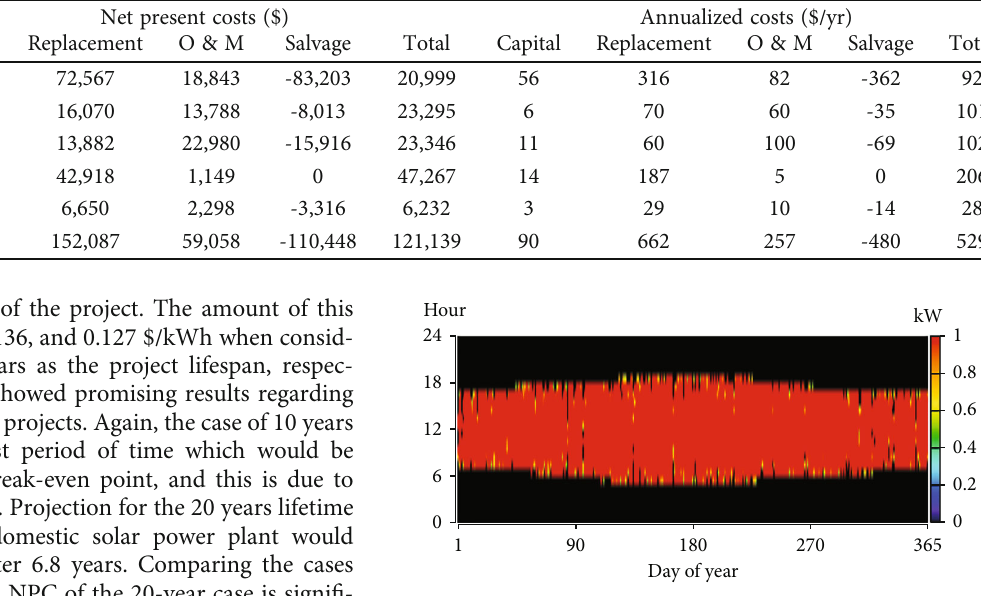
Figure 7: Electrolyzer input power.